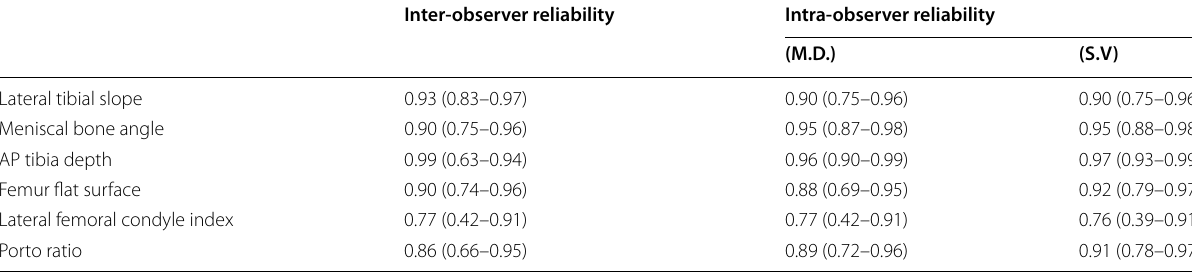
Table 2 Inter- and intra-observer reliability of morphological parameters a